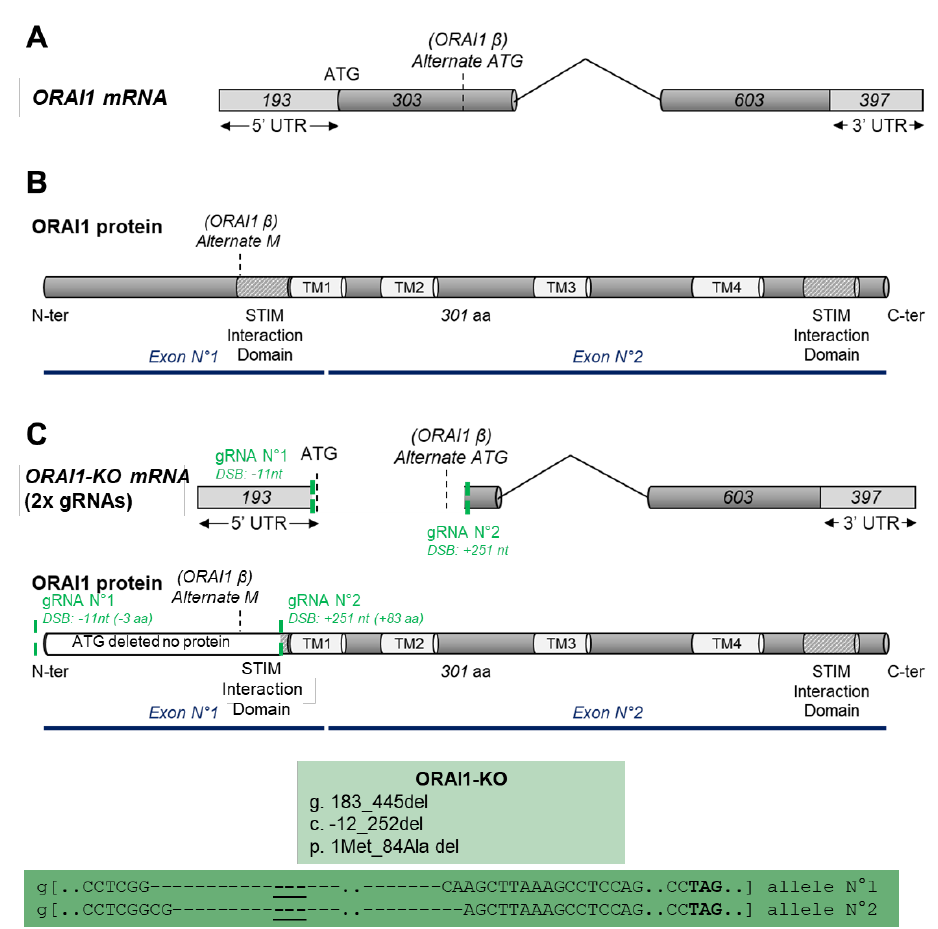
Figure 1. Experimental design of the strategy used to create total knockout of ORAI1 protein (ORAI1 KO). ( A ) Structure of ORAI1 messenger RNA (mRNA) including the noncoding region (light grey), the coding sequence (dark grey), the original start codon (ATG, full-length ORAI1 origin), and the alternative start codon (ATG, ORAI1 β isoform). ( B ) Structure of ORAI1 protein including the transmembrane domain (white boxes) and the stromal interaction molecule (STIM) interaction domain (hatched boxes). ( C ) Guide RNA (gRNA) strategy used to generate complete ORAI1 KO. The green dotted lines represent the localization of the two gRNAs used. Exact coordinates of gRNA double-strand break (DSB) induction sites (relative to the original ORAI1 ATG) are indicated next to the name of the corresponding gRNA (with nt standing for nucleotide and aa standing for amino acid). The light green insert displays the genomic (g), coding sequence (c), and protein (p) coordinates of the induced deletion. The dark green insert presents the sequences surrounding the deletion on genomic DNA level (g) for both alleles (underlined signs indicate the position of the original ORAI1 start codon).